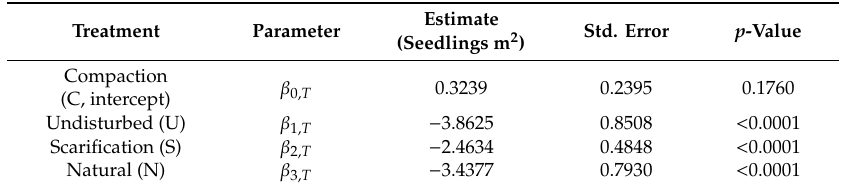
Table 3. Parameter values of Equation (1) (binomial part of the zero-inflated model), estimates, standard errors, and p -values to estimate the number of recruits (treatment e ff ect) in Spanish black pine forests subjected to treatments in Cuenca Mountains (Spain).